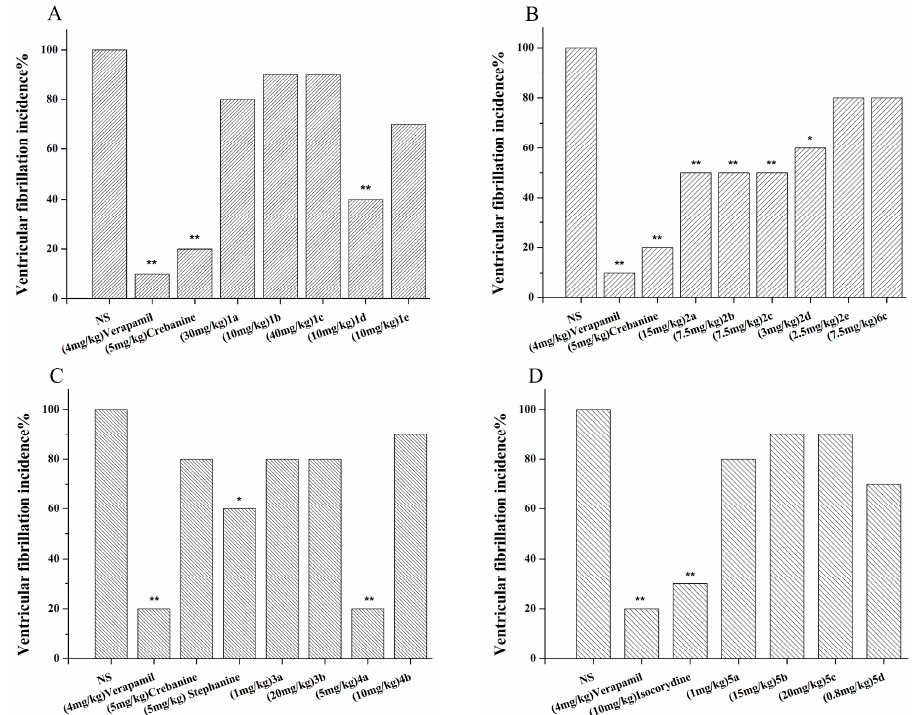
Figure 1. ( A – D ) Antiarrthymic activity of 19 aporphine derivatives in a mouse VF model, induced by CHCl 3 ( n = 10). Data represent the incidence percentage of VF in 10 experiments. Significantly different from the control group, * p < 0.05, ** p < 0.01. 1d , 2a , 2b , 2c , 2d , and 4a possess significant antiarrhythmic effects. Table 2. Acute toxicity tests of three crebanine derivatives ( 2b , 2c , and 2d ) in mice ( n = 10). Compounds LD 50 (mg/kg) 95% Confidence Intervals (CIs) 10,11-Dibromocrebanine ( 2b